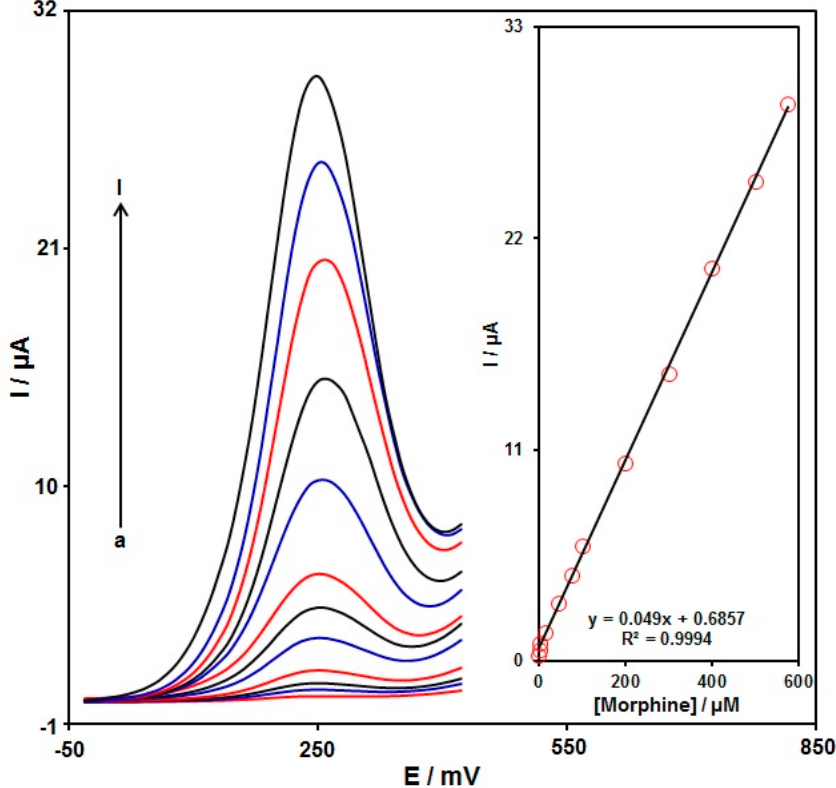
Figure 9. DPVs captured for the oxidation of variable morphine contents on the graphene- Co 3 O 4 /SPGE under variable contents (a–l: 0.02, 0.25, 2.5, 15.0, 45.0, 75.0, 100.0, 200.0, 300.0, 400.0, 500.0, and 575.0 µM); Inset: Calibration curve of voltammetric response (Ipa) against morphine level. Table 1. Comparison of the efficiency of the graphene-Co3O4/SPGE sensor with other reported modified electrodes for morphine determination.